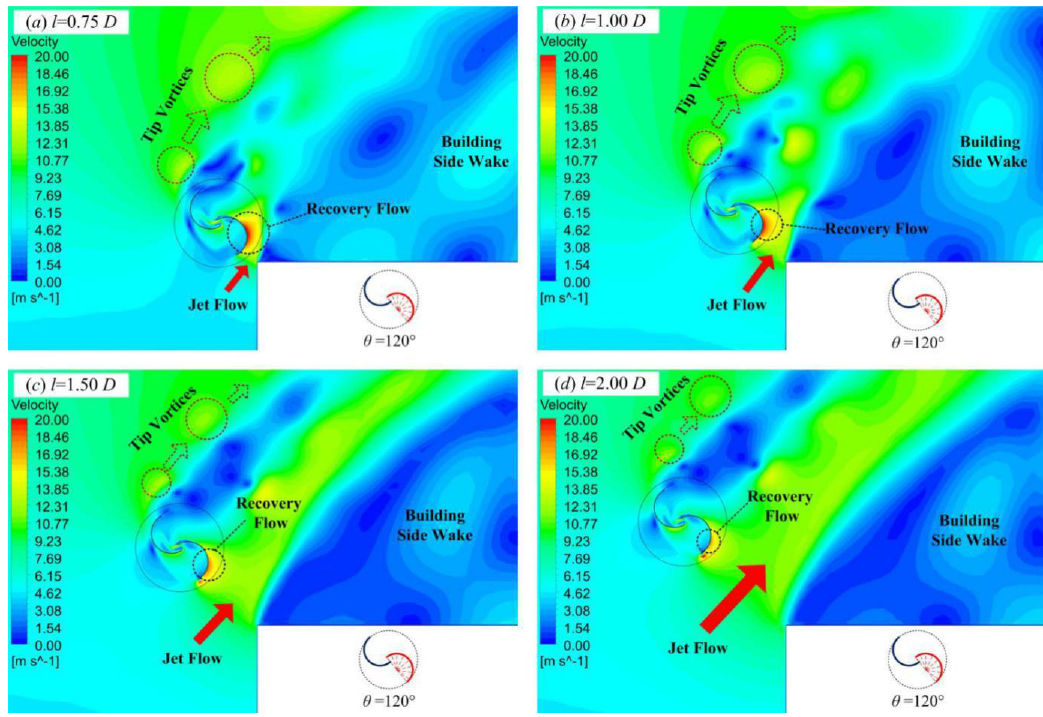
Figure 12. Contours of velocity near the turbines at θ = 120° and at different installation positions.